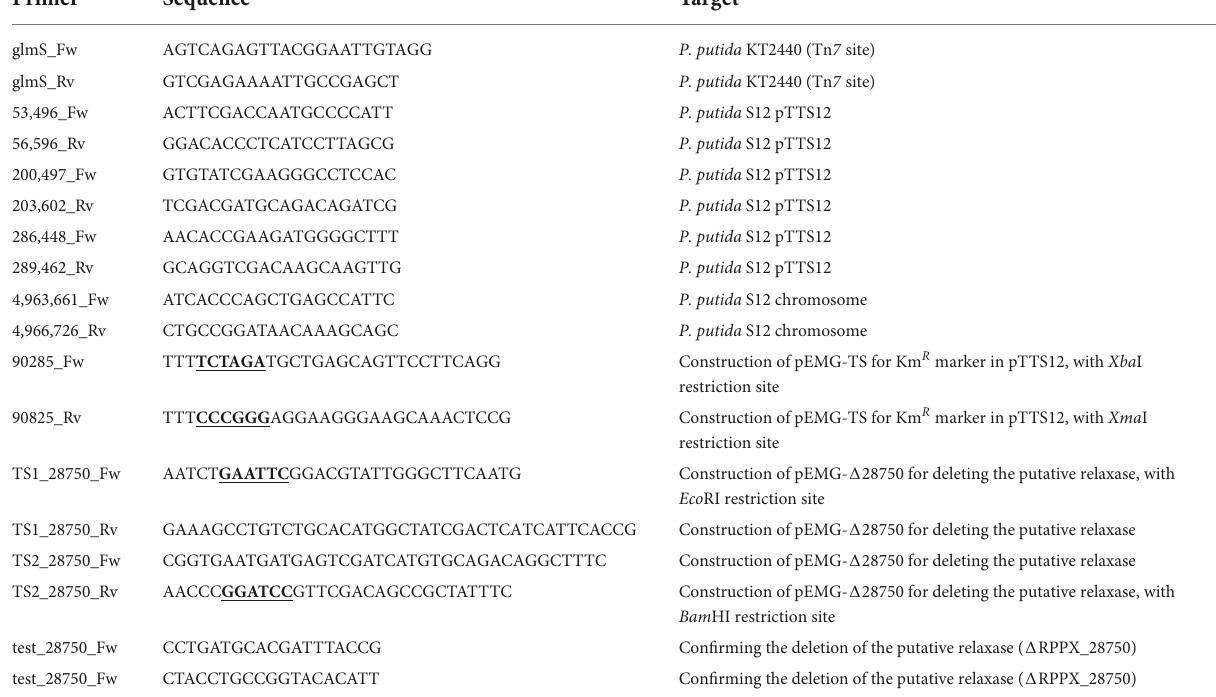
TABLE 2 Primers used in this